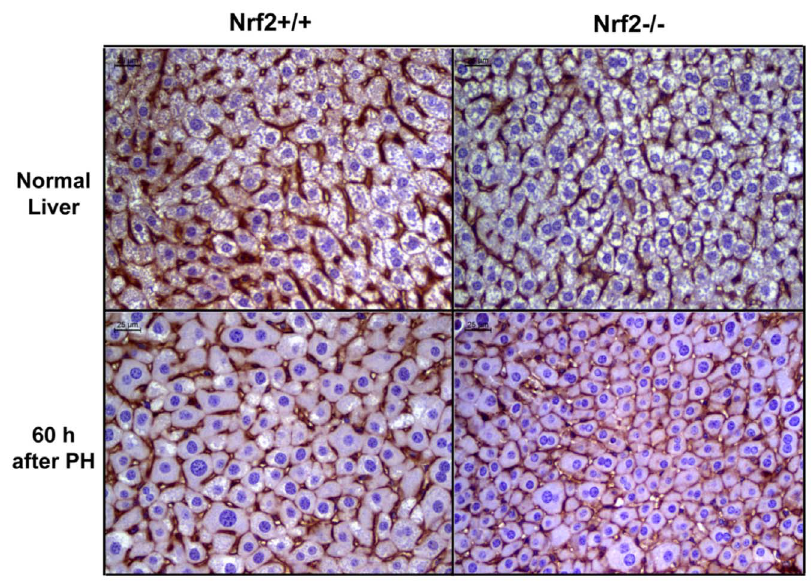
Figure 2. b -catenin immunostaining. Liver sections were prepared from the resting livers and the livers at 60 h after PH in Nrf2 + / + and Nrf2 2 / 2 mice and subjected to immunostaining with b -catenin primary antibody. Hepatocyte membrane was stained dark brown.